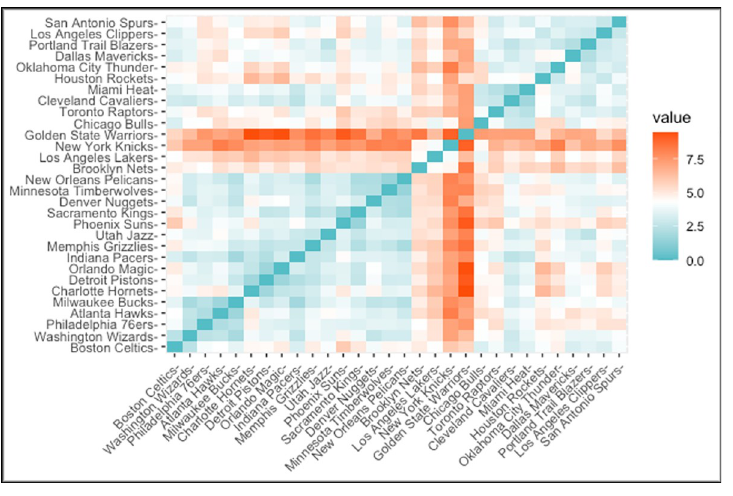
Fig 5. Distance matrix of the